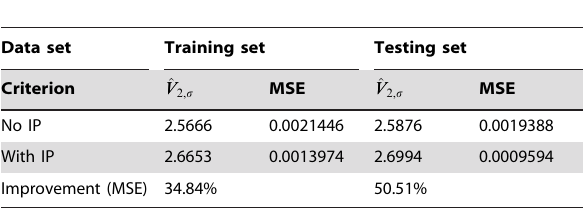
Table 3. Performance comparison for the RNN using ‘‘MG’’. Table 4. Performance comparison for the RNN using